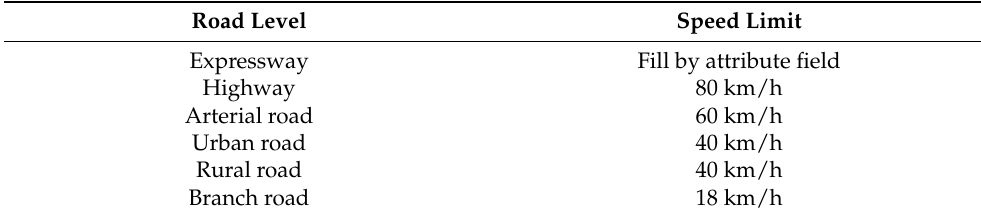
Table 3. Speed limit for various levels of roads.